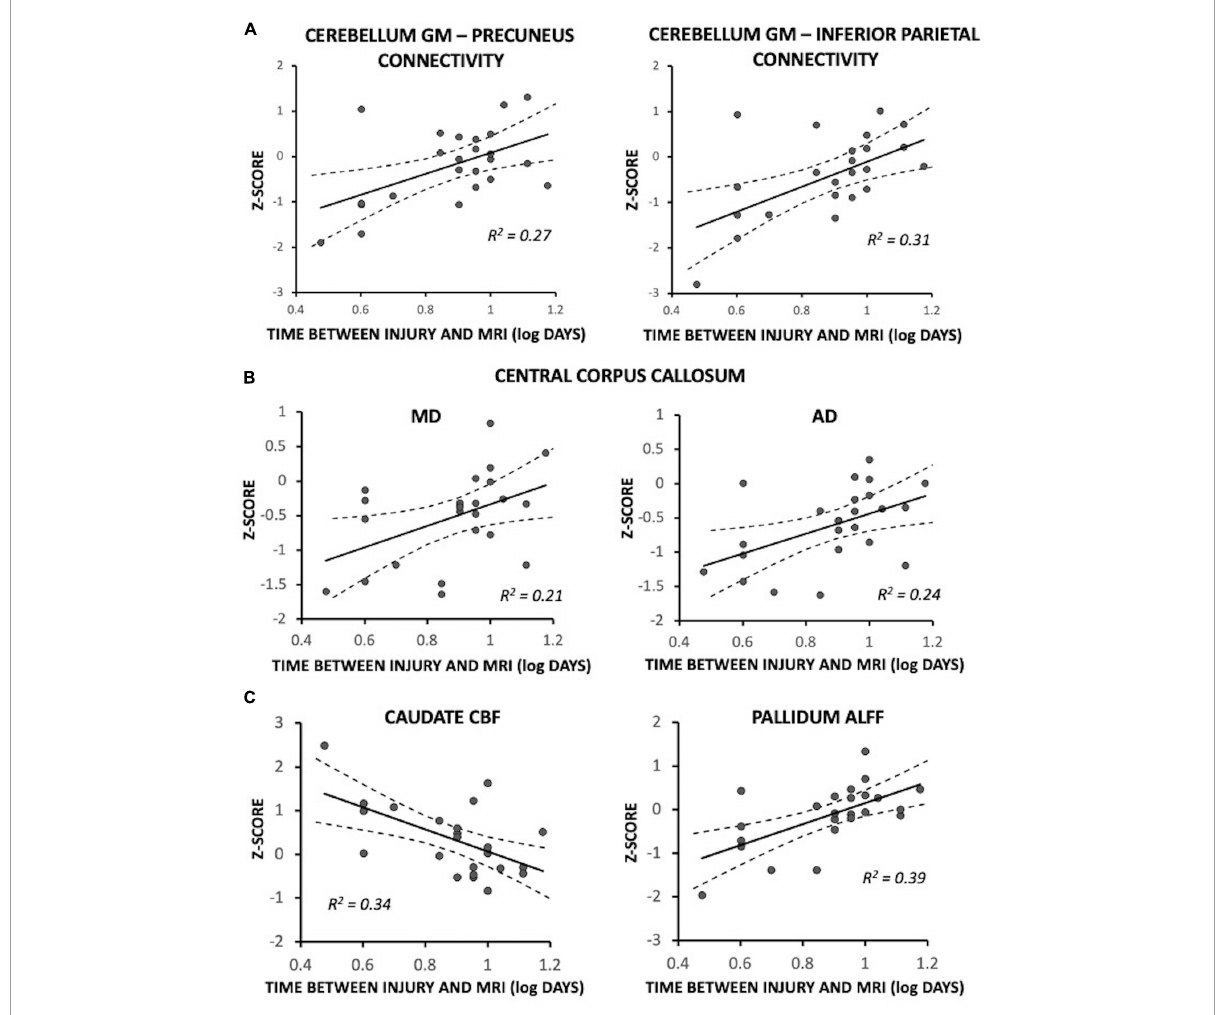
FIGURE3 Magnetic resonance imaging (MRI) measures associated with time between injury and MRI in symptomatic recently concussed youth ( N = 24), expressed as a Z-score relative to control participants ( N = 20). Fewer days between injury and MRI was significantly associated with: (A) decreased functional connectivity between the cerebellum and each of the precuneus ( p = 0.014) and the inferior parietal lobule ( p = 0.007); (B) decreased MD ( p = 0.037) and AD ( p = 0.022) of the central corpus callosum; and (C) increased CBF in the caudate ( p = 0.005) and decreased ALFF of the pallidum ( p = 0.002). More days between injury and MRI was associated with near control participant levels (i.e., Z =